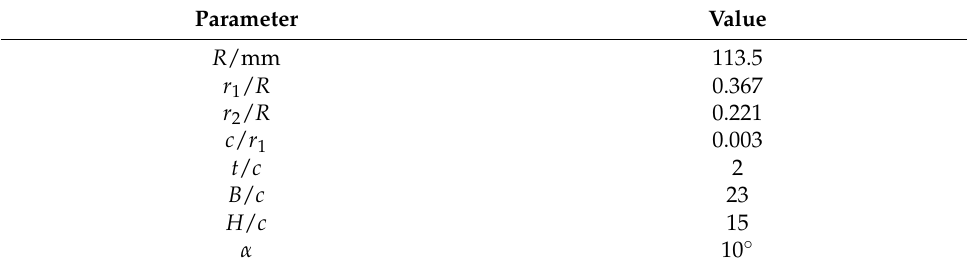
Figure 2. Simplified model of the turbine disk cavity and inlet labyrinth seal. Table 1. Main geometric parameters.